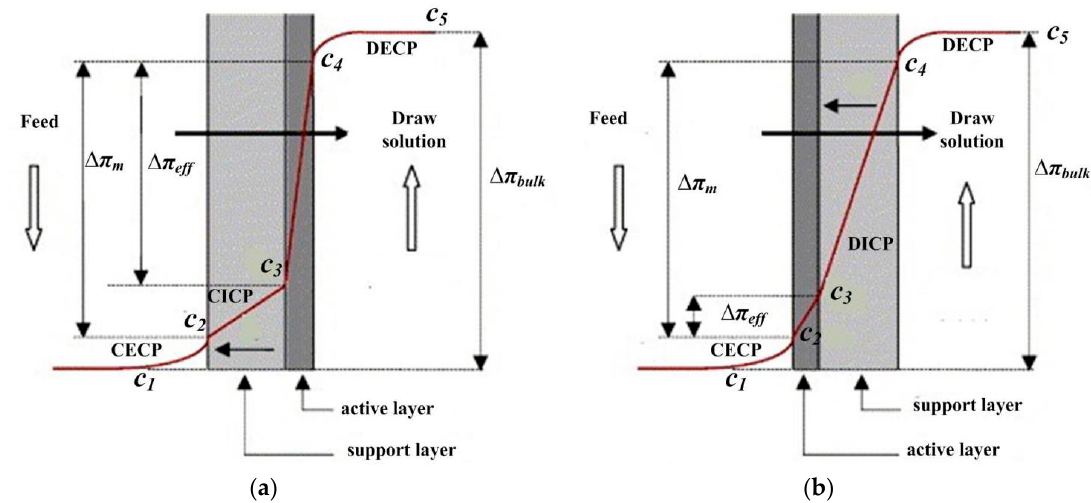
Figure 2. An asymmetric dense membrane with the porous support layer facing the feed solution ( a ) and draw solution ( b ). The profile illustrates concentration polarization, respectively. CECP: concentrative external concentration polarization, CICP: concentrative internal concentration polarization, DECP: dilutive external concentration polarization and DICP dilutive internal concentration polarization, Δπ m : the osmotic pressure difference between concentrative feed ( C 2 ) and dilutive draw solution ( C 4 ) on both outer sides of the forward osmosis membrane, Δ π bulk the osmotic pressure difference between feed ( C 1 )and draw solution ( C 5 ), Δ π eff : the effective osmotic pressure difference between further concentrative feed ( C 3 ) and dilutive draw solution ( C 4 ) on both sides of the active layer, C (1–5): the concentration of solution in different positions.